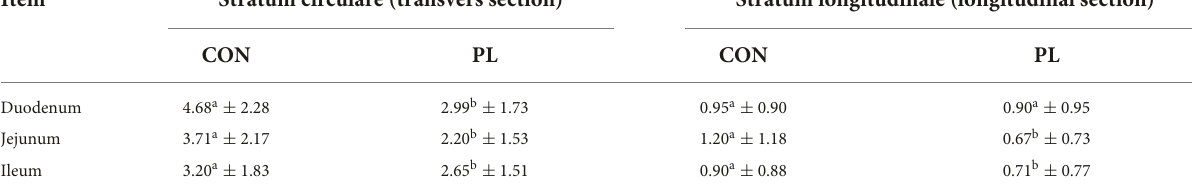
TABLE 9 Mean number of nuclei (n/cell 40 µ m × 40 µ m) in the stratum circulare (transvers section) and stratum longitudinale (longitudinal section) of the tunica muscularis of the animals in both groups (mean ± SD). Item Stratum circulare (transvers section) Stratum longitudinale (longitudinal